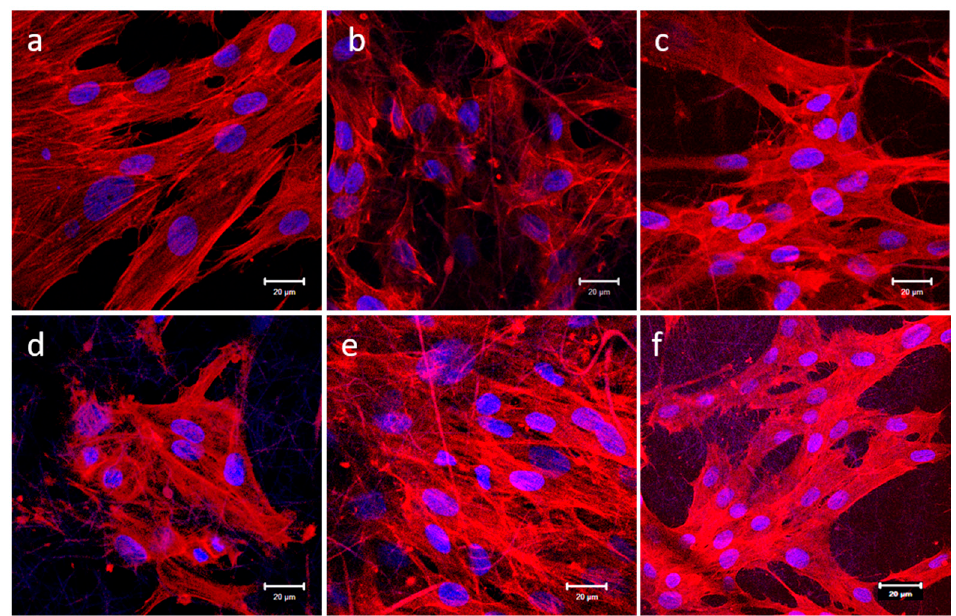
Figure 9. Immunofluorescence analysis of fibroblast expression of specific marker protein F-actin (red) on Day 9 ( a ) TCP, ( b ) PCL, ( c ) PCL/AV, ( d ) PCL/CUR, ( e ) PCL/AV/CUR ( f ) PCL/AV/TCH. Scale bar = 20µm.